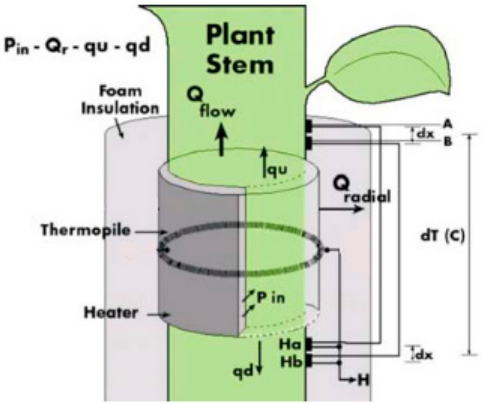
Figure 3. Sensor scheme for the energy balance calculation of sap flow (Dynamax Inc., 2020) [30]. Thermocouples A and B are placed above the heater and thermocouples Ha and Hb are placed below the heater to measure the difference between temperature above and below the heater.